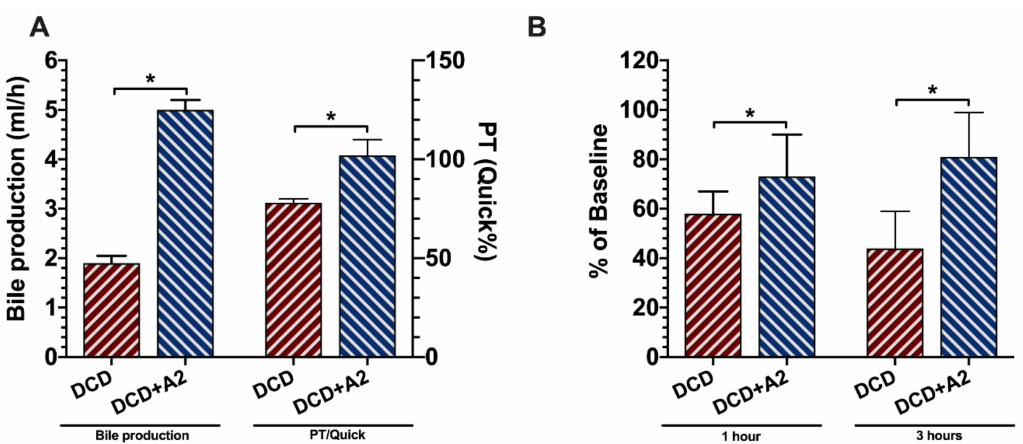
Figure 2. Graft functional recovery. ( A ) Bile production is presented as total amount of bile collected over the 1st hour of reperfusion in the DCD and DCD + A2 groups. Prothrombin time (PT) / Quick values at post-operative day 3 (POD3) following orthotopic liver transplantation (OLT) in the DCD and DCD + A2 groups. ( B ) Indocyanine green (ICG) plasma disappearance rate was measured in the DCD and DCD + A2 groups at 1 h and 3 h after reperfusion and presented as a percentage of ICG eliminated compared to baseline. (mean ± s.e.m., * p < 0.05 DCD + A2 vs. DCD, Student’s t -test, n = 5 /